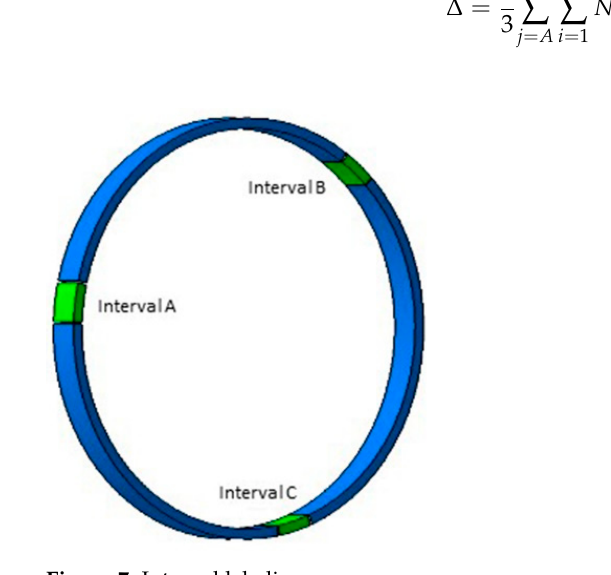
Figure 7. Interval Figure 7. Interval labeling.